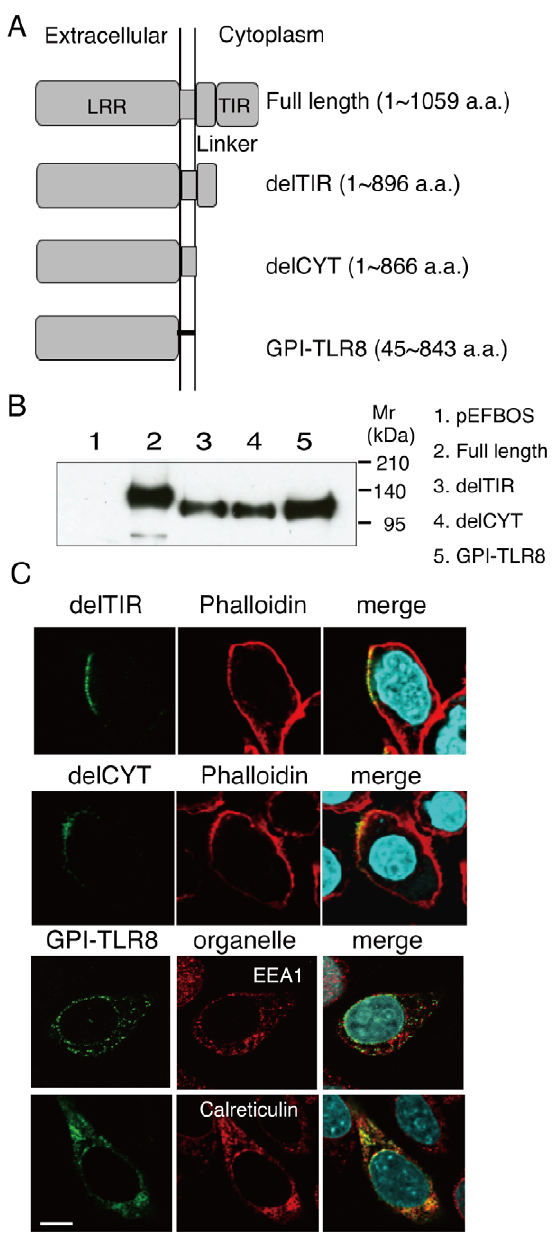
Figure 2. Defining the TLR domain responsible for localization. A , Schematic diagram of the tail-deletion constructs of hTLR8. B , Expression of the TLR tail-deletion constructs in HEK293FT cells. Wild- type and mutant proteins transiently expressed in HEK293FT cells were immunoprecipitated with anti-FLAG mAb, resolved using SDS-PAGE, and detected using immunoblotting with anti-FLAG mAb. Molecular weight markers are shown on the right. C , Immunofluorescence images of the TLR8 deletion constructs in transfected HeLa cells. The upper and middle panels show cells stained with delTIR and delCYT together with phalloidin, which labels the plasma membrane. The lower two panels show cells stained with GPI-TLR8 together with EEA1 or calreticulin. Green, TLR8 mutants; red, organelles; blue, nuclei stained with DAPI; bar, 10 m m.